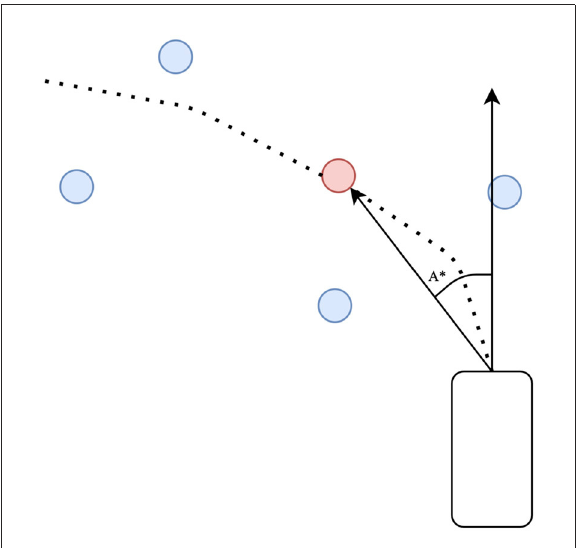
FIGURE4 Lateral PID controller. The red waypoint is obtained by fitting a curve with four blue predicted waypoints. A ∗ is the target steering